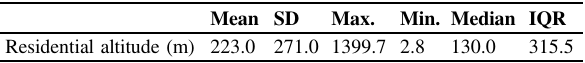
Table 1 Distribution of the baseline categorical variables of the Table 2 Distribution of the altitude of the participants (N =